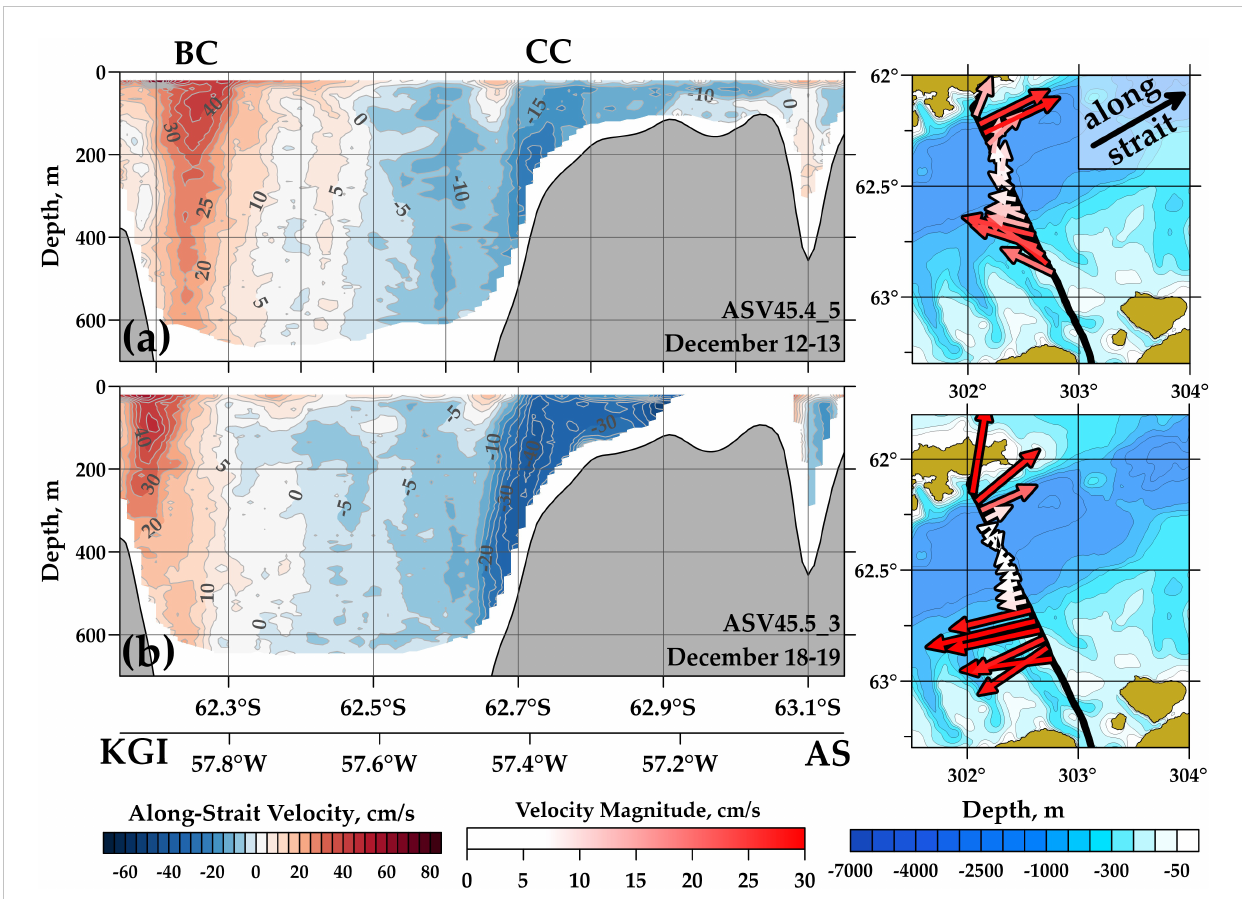
FIGURE 8 Along-strait velocity distributions at two crossings between King George Island (KGI) and Antarctic Peninsula near the Antarctic Sound (AS) performed on December 12-13 (A) and December 18-19 (B) . Positive values of velocity correspond to the east-north-east direction (the exact value is 60° relative to the north; this direction is shown by black arrow in the upper right panel). The velocities were projected to the direction along the strait independently on the orientation of transects. The measurements were performed from the R/V ASV. Locations of the crossings are shown in the right panels together with the depth-averaged SADCP velocities. The ocean bottom is shown by grey color. KGI, King George Island; AS, Antarctic Sound; BC, Brans fi eld Current; CC, Antarctic Coastal